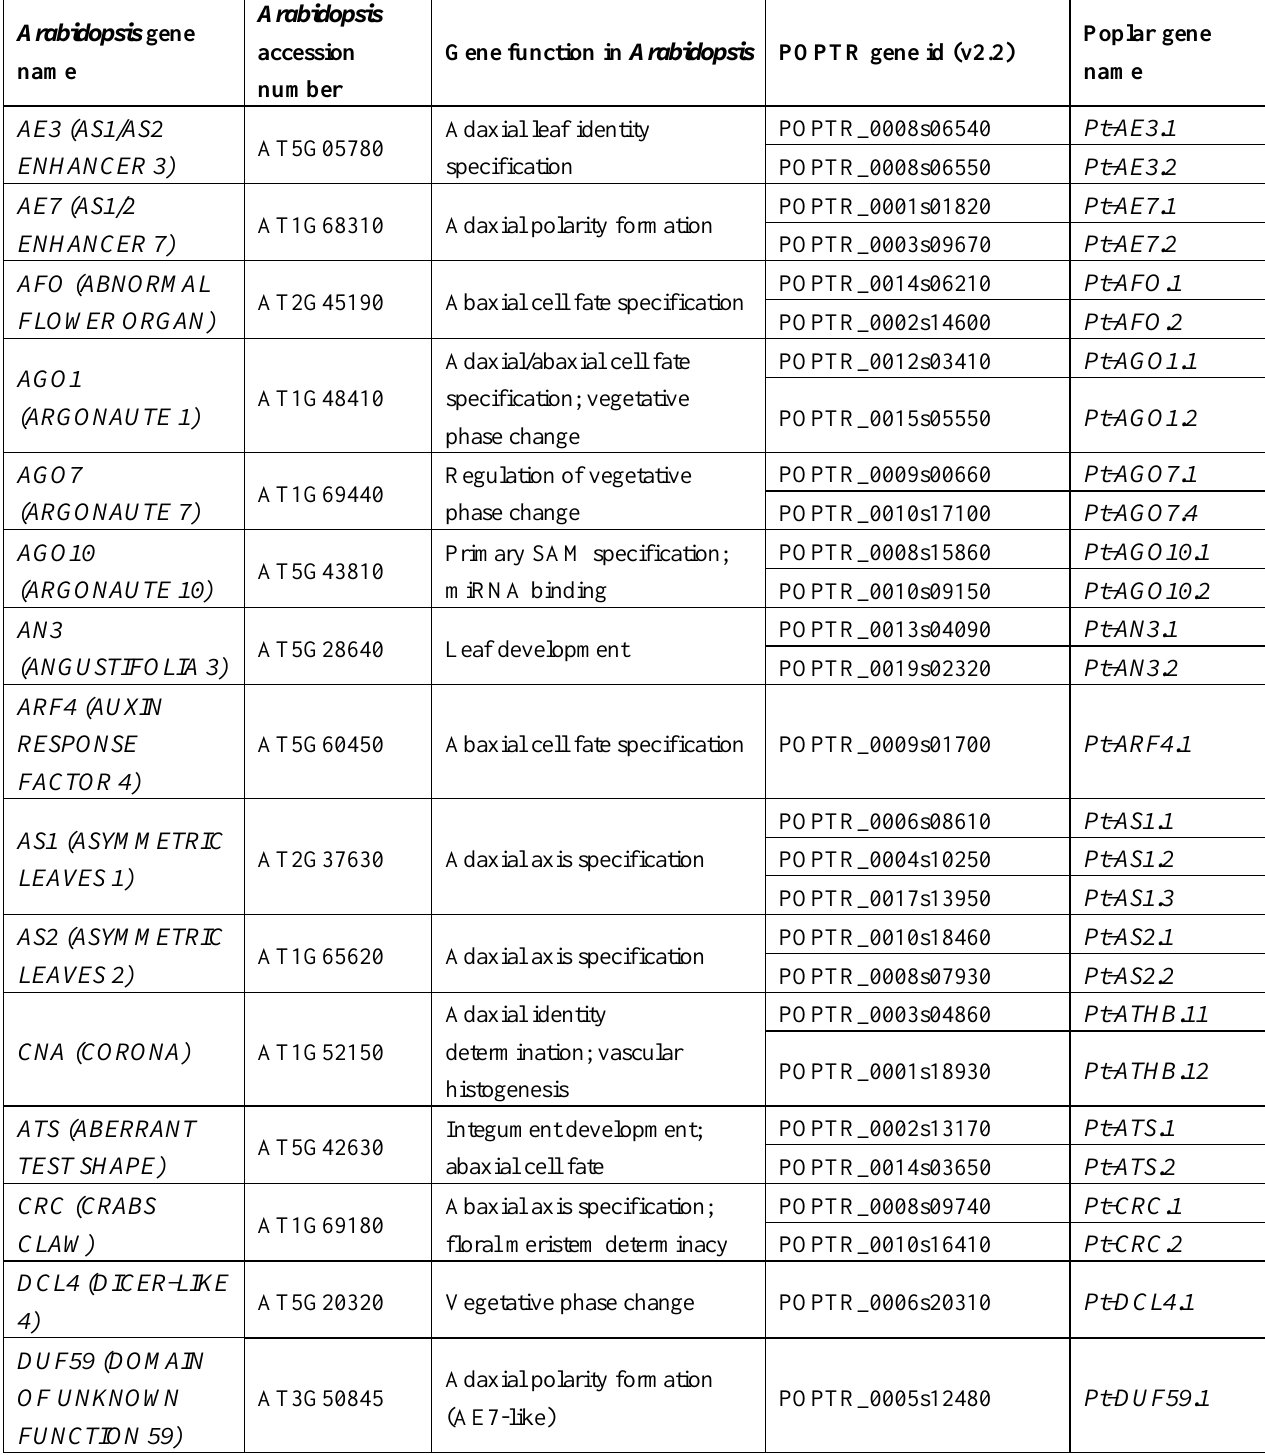
Table S1. Arabidopsis genes names and identified putative P. trichocarpa orthologs, including poplar gene id and gene name. Gene function in Arabidopsis , from various references (cited within text or TAIR), is also